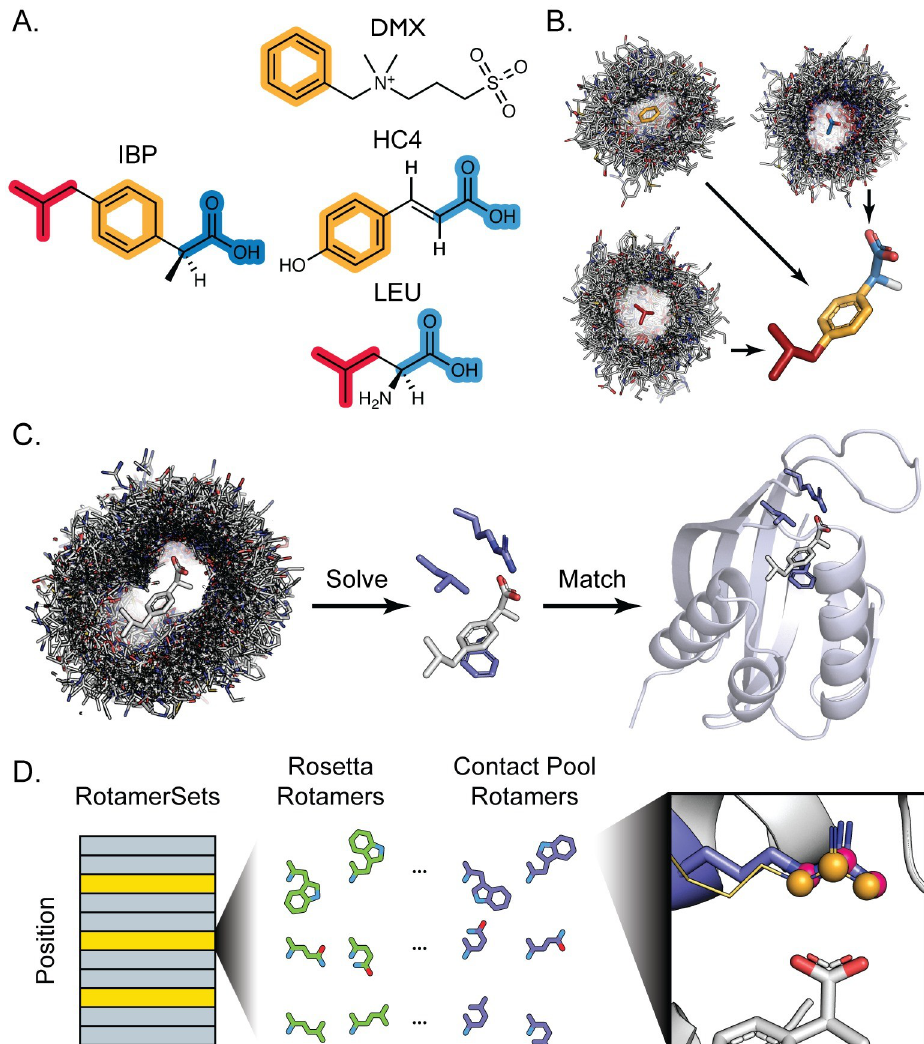
Fig 1. Protocol Overview. A. Target small molecules are decomposed into fragments (highlighted red, orange, and blue) that are present as a substructure in a wide range of molecules bound to proteins in the PDB. B. Protein complexes bound to substructure-containing molecules are systematically parsed to generate contact pools representing all contact modes with each fragment present in the PDB. These contacts are mapped onto the full target ligand (here ibuprofen) to create a conformer-specific contact pool for downstream steps. C. A simulated annealing protocol is used to assemble hundreds of thousands of three-residue composite binding sites from a target ligand contact pool. RosettaMatch is then used to find scaffold proteins that can geometrically accommodate a composite binding site solution. D. Sequence design is performed by Rosetta’s design machinery, where positions in the protein can be set to designable (yellow bars) or not designable (grey bars). Contact pools are used to supplement the set of rotamers generated by Rosetta for designable positions. Rotamers are built in the context of a potential ligand interface and any rotamers (purple sticks, pink spheres) that recapitulate an interaction in the contact pool (gold lines, orange spheres) are added to the standard RotamerSet (green) and provided a score bonus with the special_rot score term.